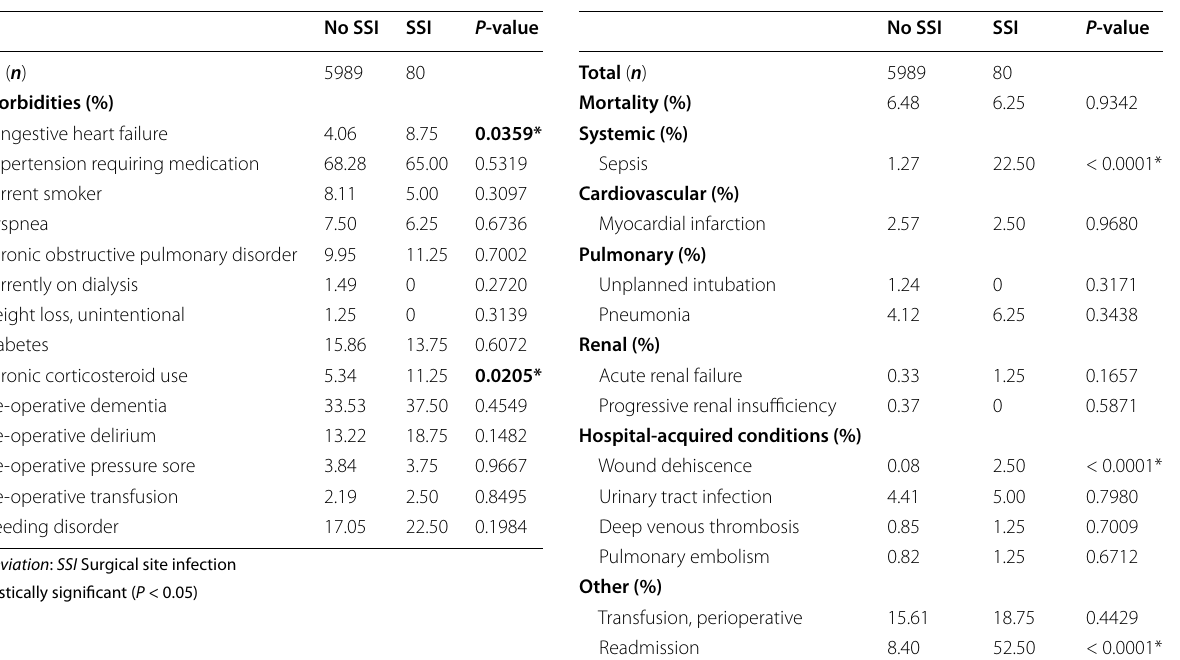
Table 2 Comorbid conditions of geriatric patients undergoing hip hemiarthroplasty stratified by occurrence of surgical site infection